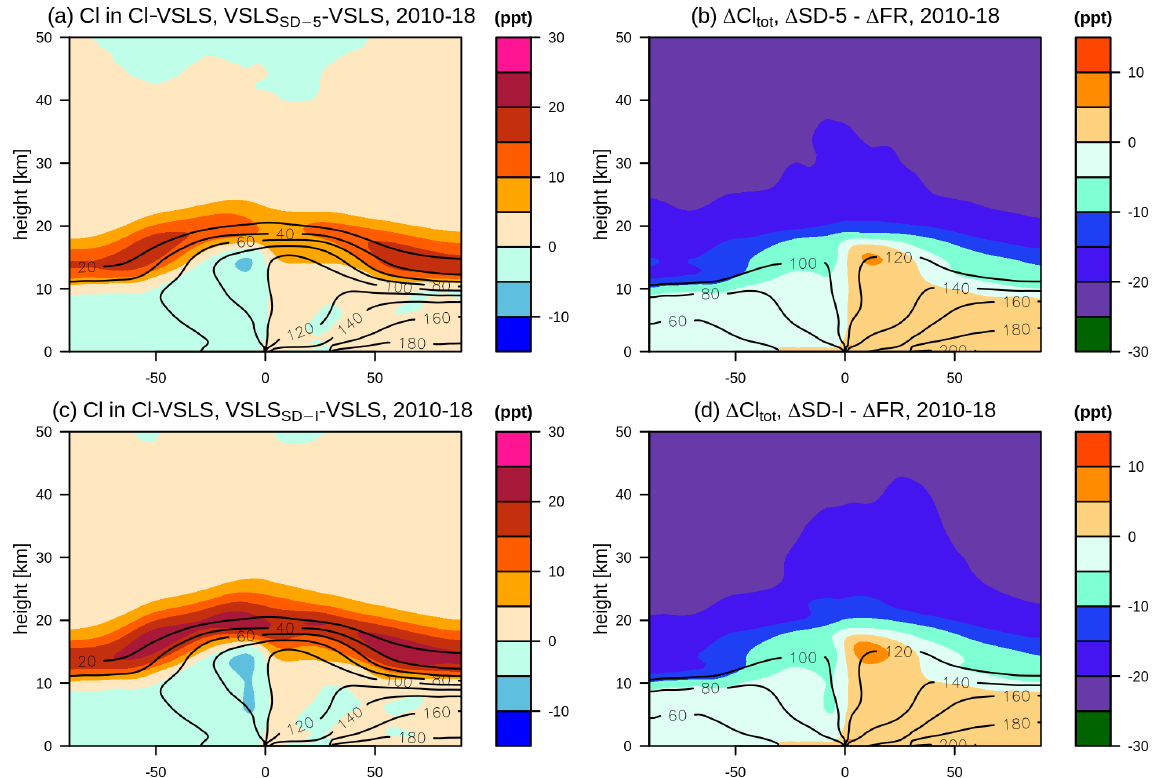
Figure 5. Shading: 2010-2018 difference in Cl [ppt] in (a, c) Cl-VSLS source gases between (a) VSLS SD-5 and the ensemble mean VSLS, and between (c) VSLS SD-I and the ensemble mean VSLS; (b, d) the difference between the Cl tot responses in (b) (cid:49) SD-5 and (cid:49) FR and in (d) (cid:49) SD-I and (cid:49) FR. Contours show the corresponding values in the free-running VSLS for